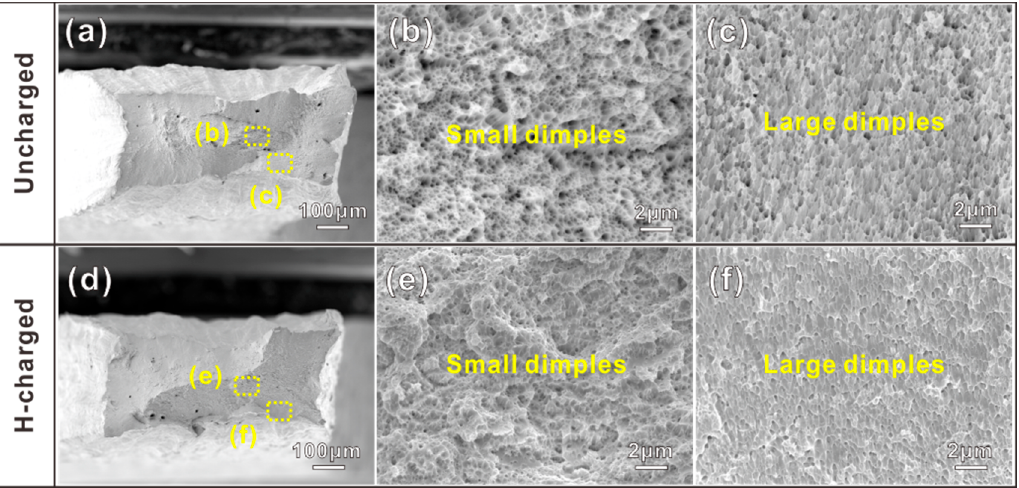
Figure 5. Tensile fracture surfaces of ( a – c ) uncharged sample; ( d – f ) H ‐ charged sample. ( b – c ) and ( e – f ) are the detailed SEM images of the dotted squares in ( a ) and ( d ), respectively.